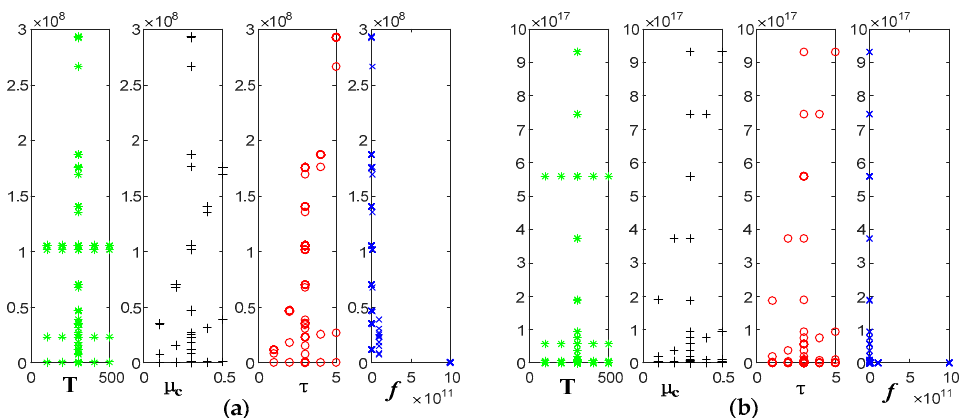
Figure 14. Linear correlation between T, μ c , τ , f, and dielectric constant: ( a ) real part; ( b ) imaginary